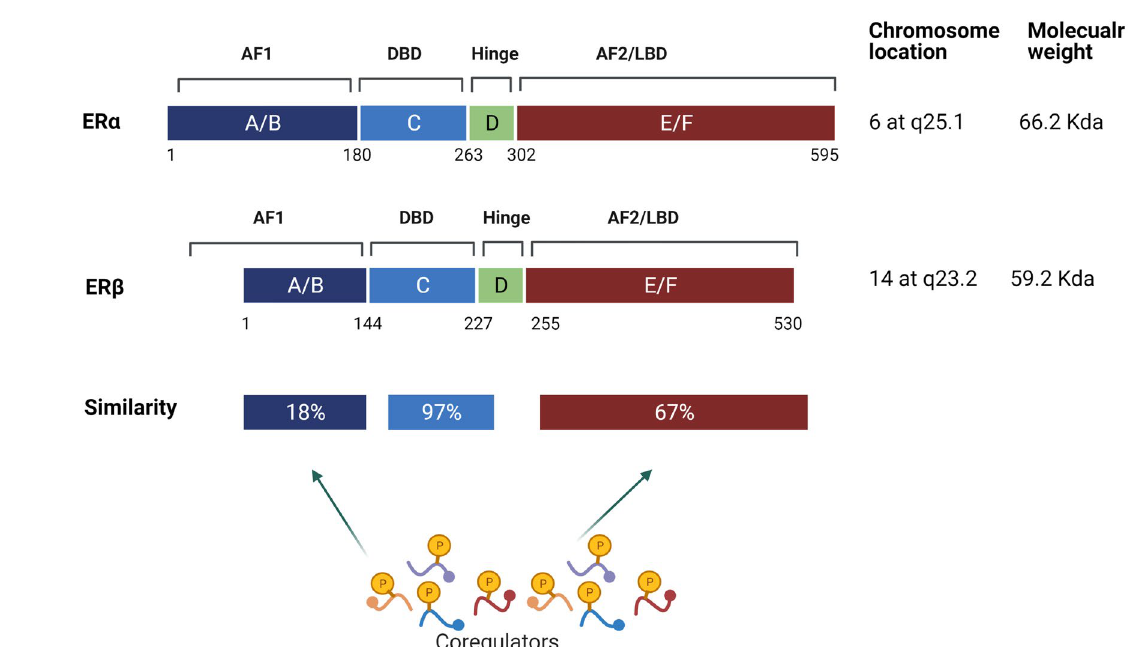
Figure 1. Schematic representation of various domains in ERα and ERβ. ERs consist of six domains labelled A through F. The activation of AF1 region is located in A/B-domain and the DNA binding region is located in the C-domain. The D-domain contains a flexible hinge region. The E-domain contains the ligand-dependent activation of function domain (AF2). The F domain contributes to differences in the activity of ERα and ERβ subtypes and is also involved in receptor interactions with coregulators. Chromosomal localization and similarity between various domains of ERα and ERβ are depicted. The AF1 and AF2 domains facilitate ligand-independent and ligand-dependent interactions with coregulators, respectively. DBD: DNA binding